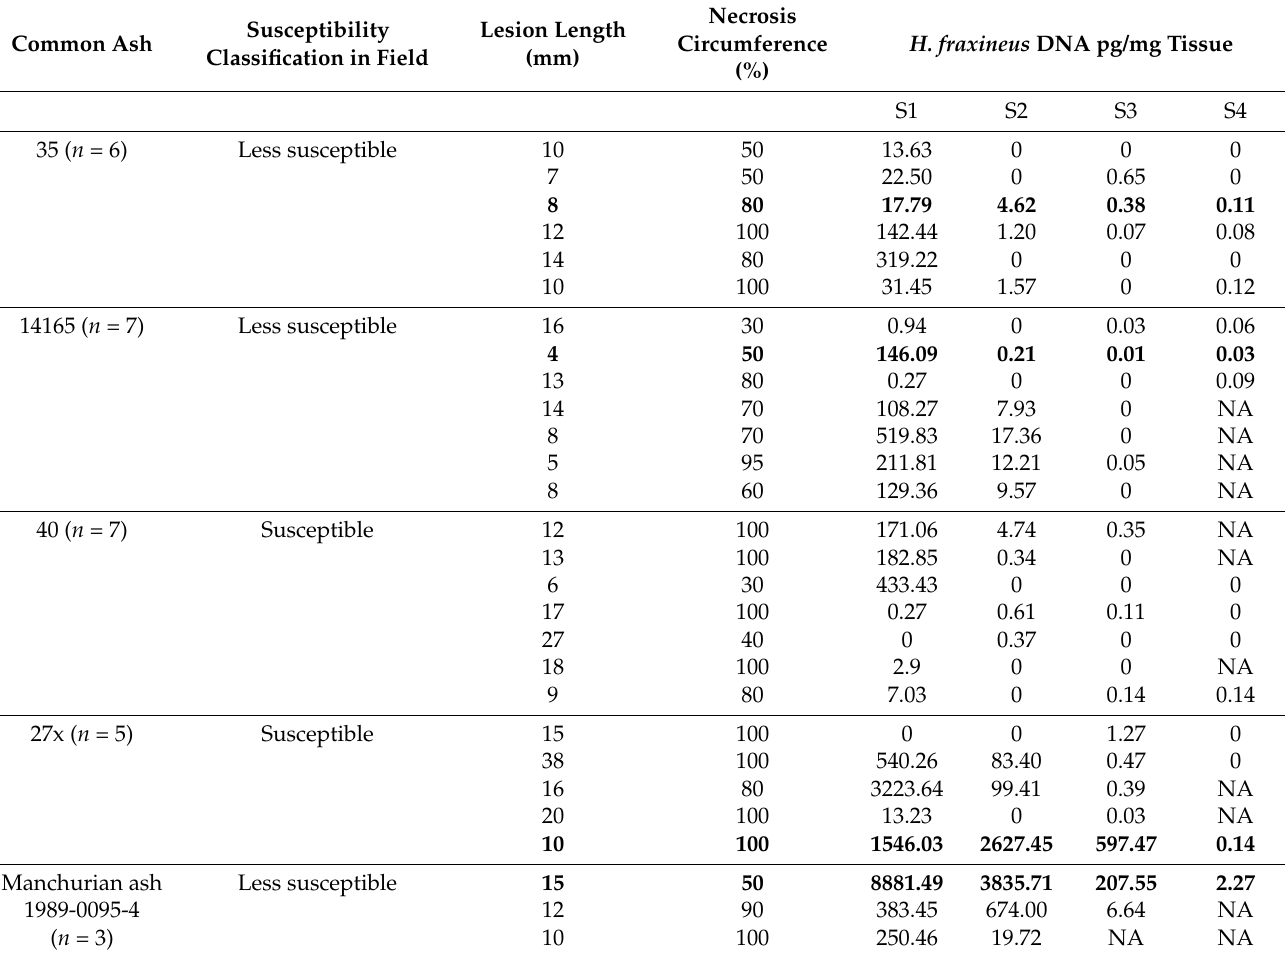
Table 1. Lesion size and level of Hymenoscyphus fraxineus DNA in inoculated rachises of common ash (four clones) and Manchurian ash (one clone) 16 weeks after inoculation. Sampling points are as follows: S1, at the border of the necrosis; S2, 1 cm away from the first sample towards the petiole base; S3, petiole base; and S4, petiole–twig junction. Samples in bold were examined with light